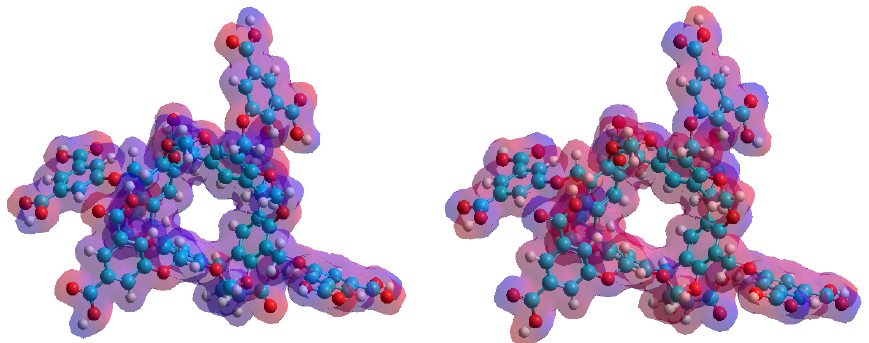
Figure 5. Kinetic energy distribution (Debye temperature) of host calixarene molecules dissolved in methanol ( left ) and dimethylformamide ( right ) solutions. Red color indicates higher while blue color indicates lower temperature regions.